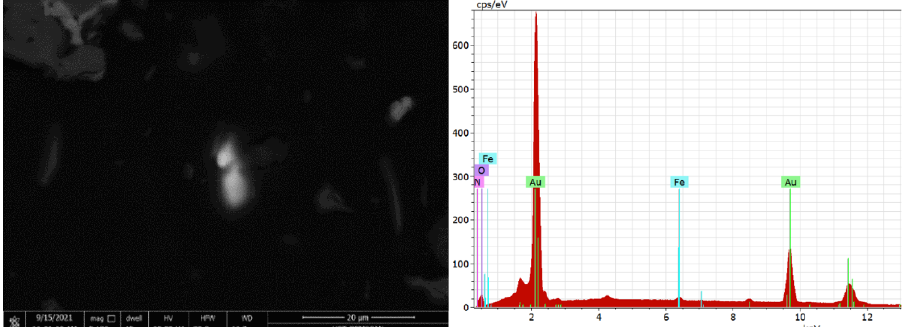
Figure 1. SEM-EDS image of gold particle in Sample 1.